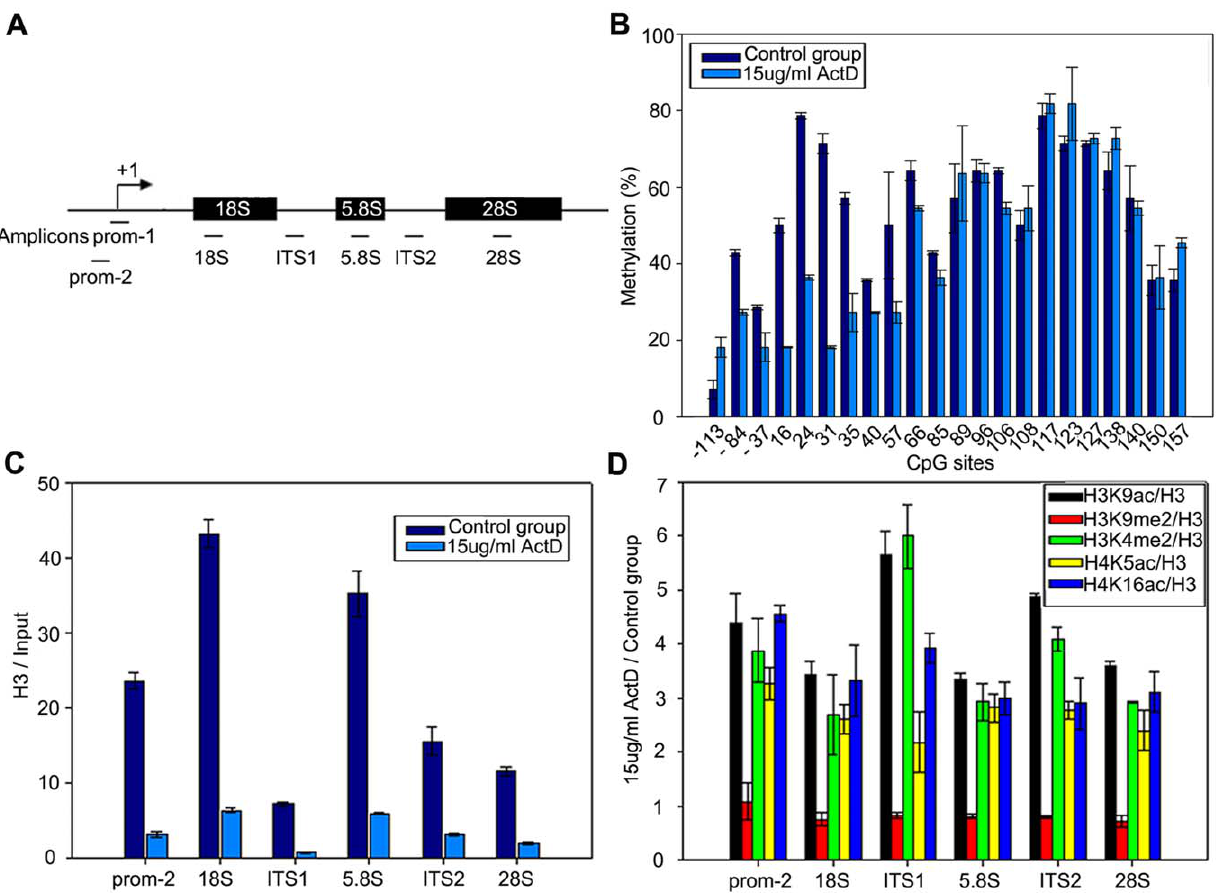
Figure 6. Analysis of DNA methylation and histone modifications of 45S rDNA regions in maize. (A) Schematic representation of the maize rRNA genes and the positions of analyzed amplicons. (B) ActD treatment induced site-specific hypomethylation within the 45S rDNA promoter. The y-axis indicated the ratio of the clones with methylation sites and the x-axis indicated positions of CpG dinucleotides from 2 113 to + 157. (C) ChIP analysis showed that the total level of histone H3 within 45S rDNA regions was decreased after treatment with 15 m g/ml ActD. DNA associated with histone H3 was immunoprecipitated with the anti-H3 antibody and primers specific for different region of 45S rDNAs were used to amplify DNA for quantitative real-time PCR. The y-axis values were the relative quantities of DNA and the x-axis indicated different regions of 45S rDNAs. Each experiment was repeated three times and the average value was shown with the SD. (D) ChIP analysis of levels of H3K9ac, H3K9me2, H3K4me2, H4K5ac and H4K16ac within 45S rDNA regions in maize after treatment without or with 15 m g/ml ActD. DNA associated with different histone modifications was immunoprecipitated with the related antibody and primers specific for different regions of the 45S rDNA were used to amplify DNA for quantitative real-time PCR. The y-axis indicated the ratio of the relative quantities of DNA in maize with ActD treatment to the relative quantities of DNA in maize without ActD treatment. Relative values were normalized to those of the total H3.The x-axis indicated different regions of 45S rDNAs. Each experiment was repeated three times and the average value was shown with the